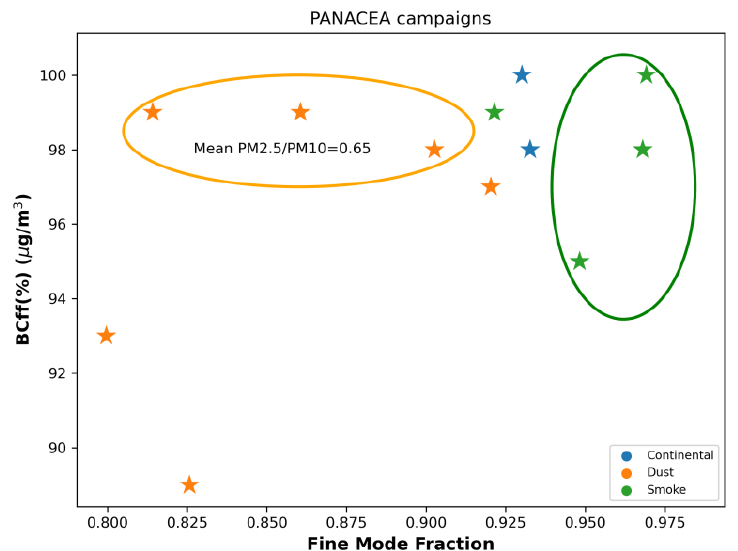
Figure 9. Dependence on the first typed aerosol layer identified with THELISYS with the Black Carbon percentages of the fossil fuel (BC ff ) to the Total Black Carbon contribution and the Fine Mode Fraction at 500 nm, from the synergistic information of the 3 instruments (i.e., Sunphotometer, Aethalometer and THELISYS) that performed measurements during the PANACEA campaigns.